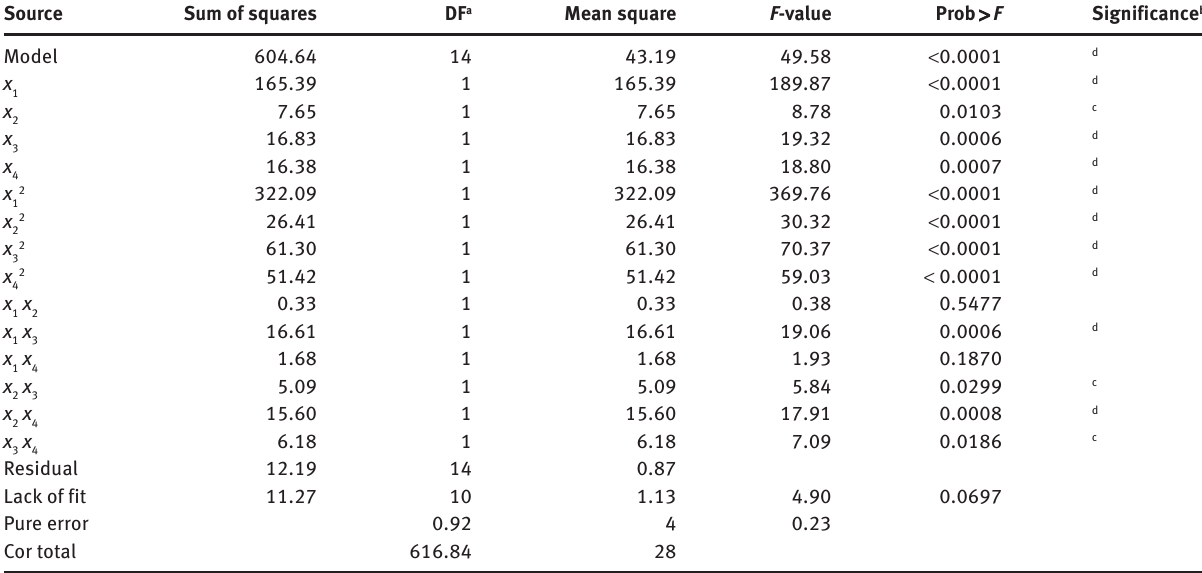
Table 4: Estimated regression coefficients and corresponding F - and p-values for BzH